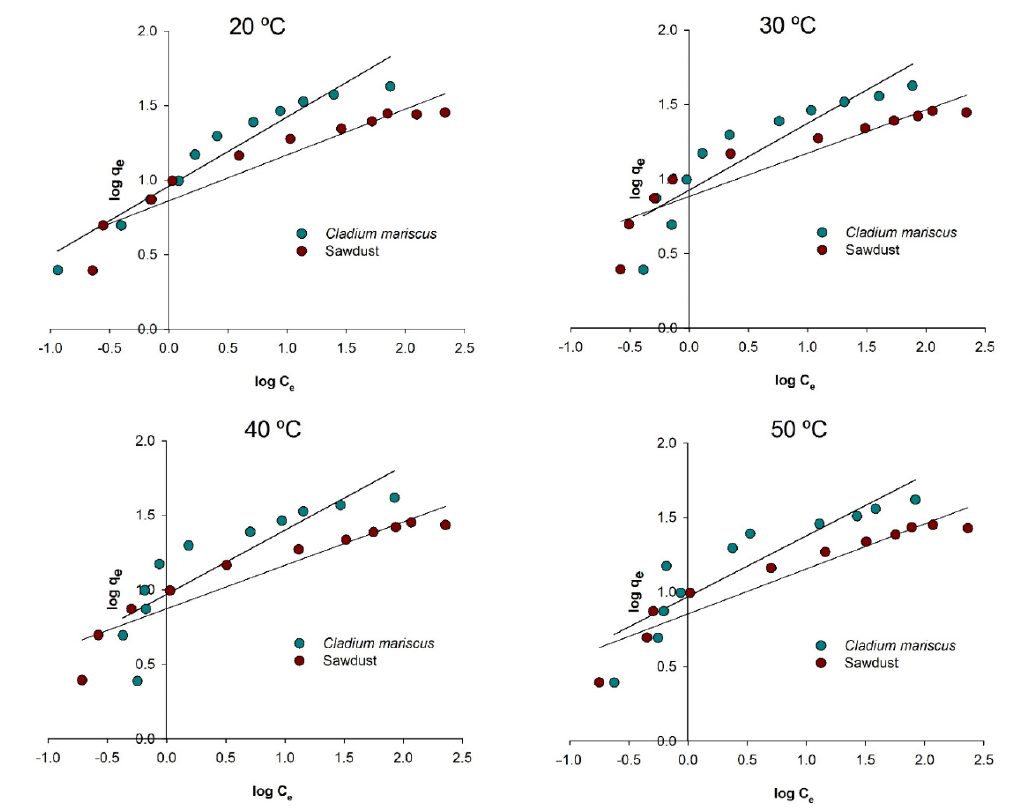
Figure 6. Freundlich isotherm model for BB3 adsorption on sawdust and Cladium mariscus saw-sedge at different temperatures.